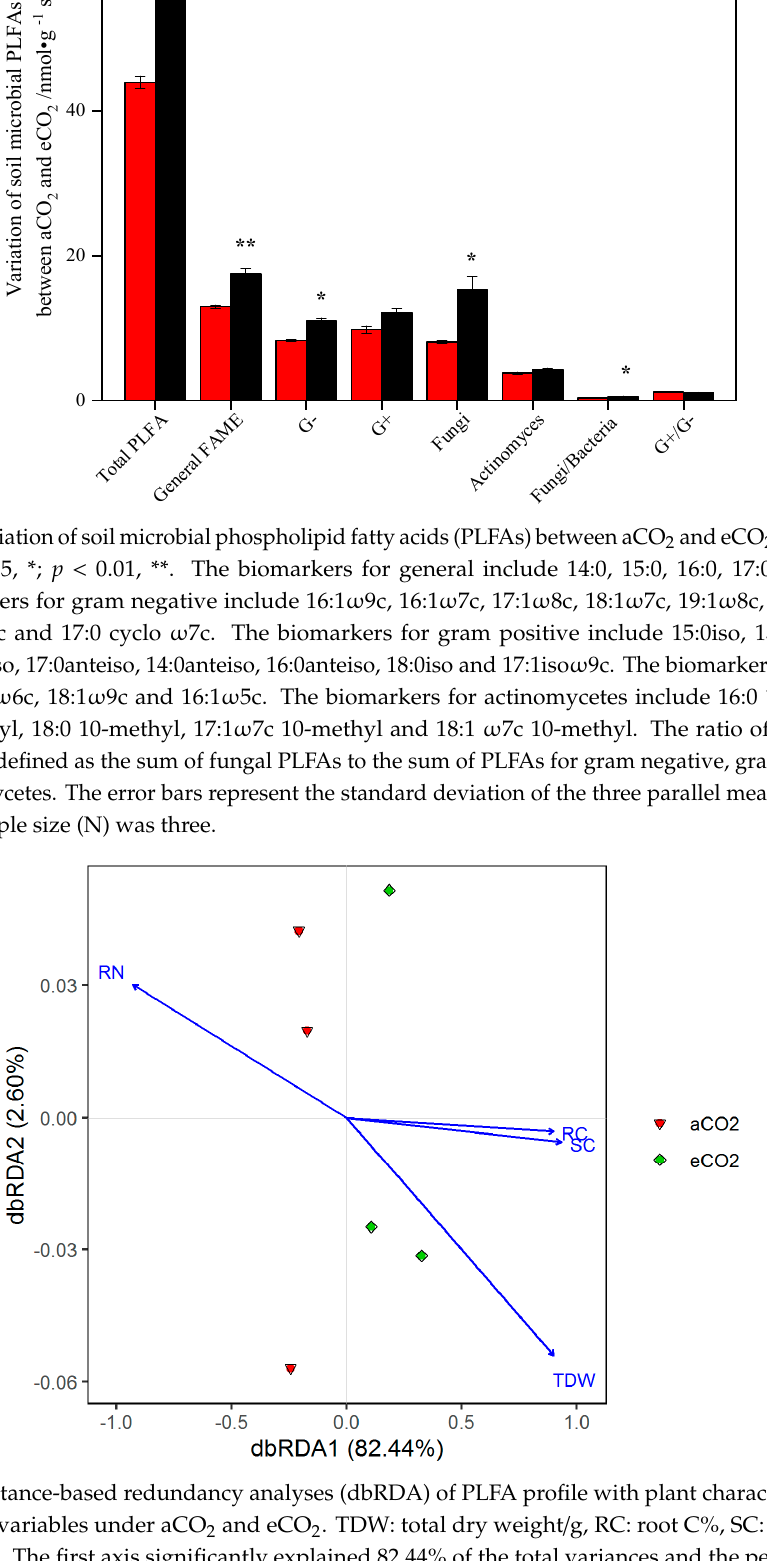
Figure 2. Distance-based redundancy analyses (dbRDA) of PLFA profile with plant characteristics as explanatory variables under aCO 2 and eCO 2 . TDW: total dry weight / g, RC: root C%, SC: shoot C%, RN: root N%. The first axis significantly explained 82.44% of the total variances and the permutation value of the overall model was 0.0889.